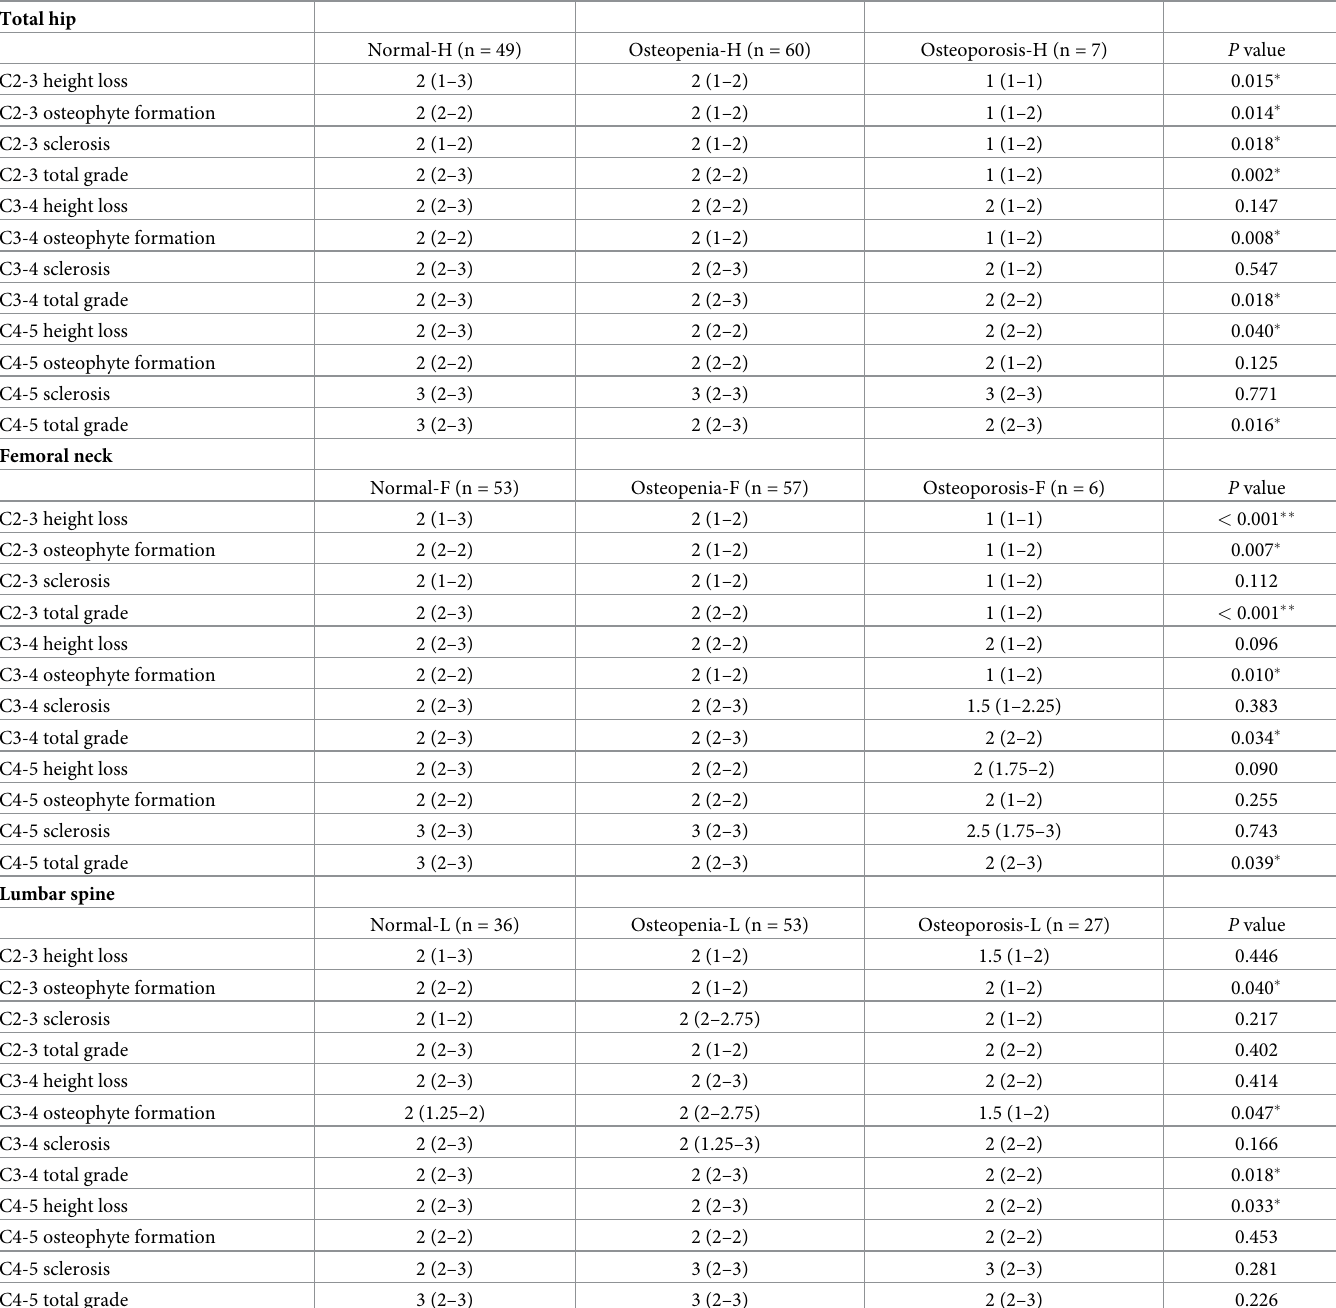
Table 2. Severity of degeneration of the cervical spine in study